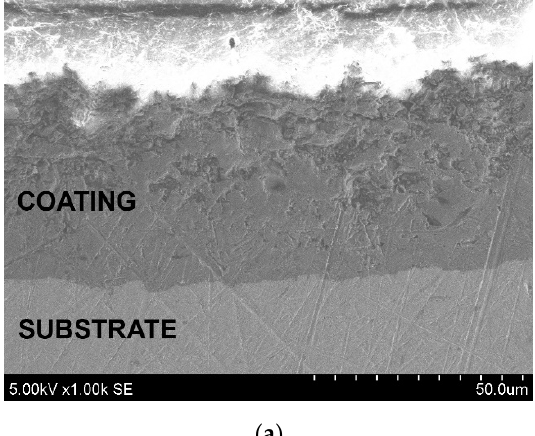
( f ) Figure 5. SEM micrographs of coating surface, using different plasma torch input powers: ( a ) 29.4 kW; ( b ) 33.6 kW; ( c ) 37.8 kW; ( d ) 42.0 kW; ( e ) 45.1 kW ; and ( f ) 45.1 kW.